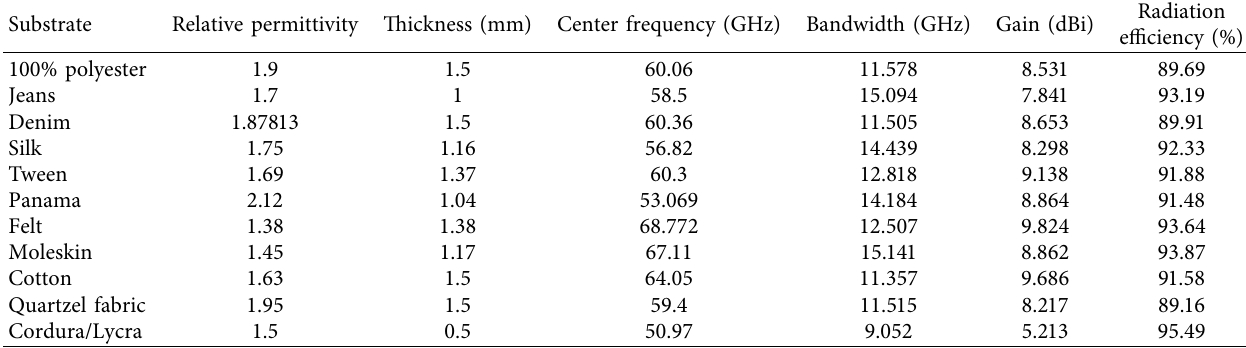
Table 7: Free-space performance summary of the antenna for different textiles.